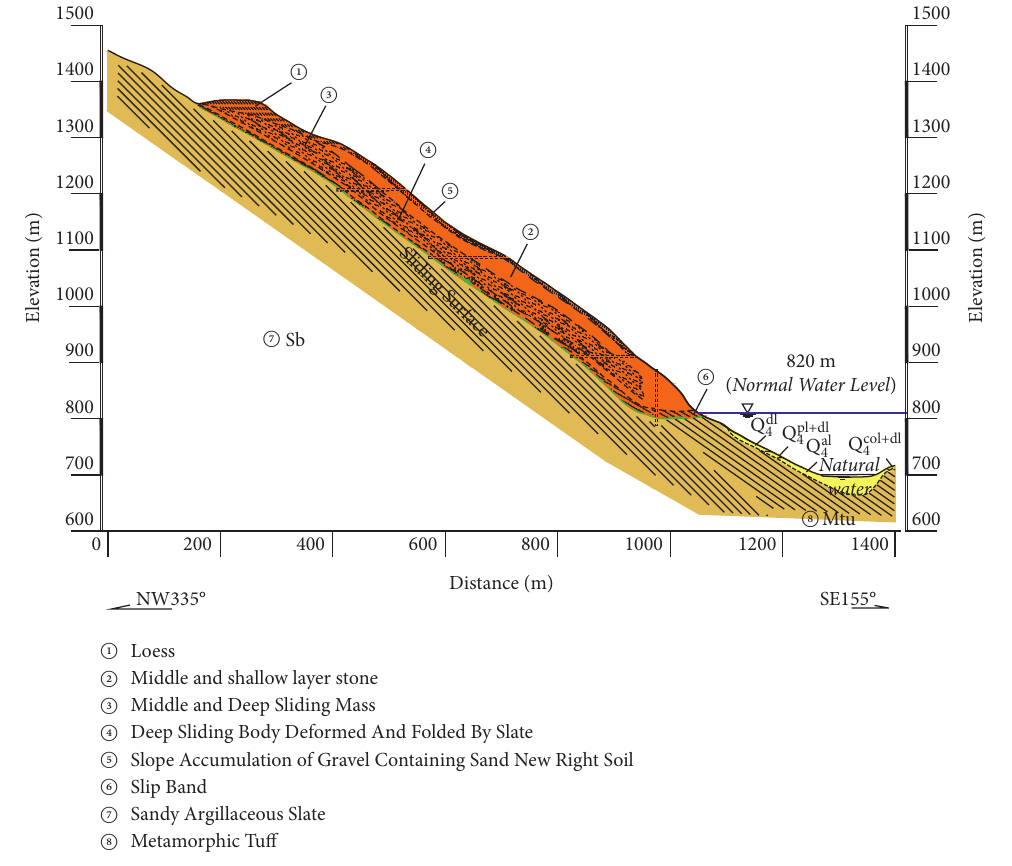
Figure 4: Typical geological profile of the Hejia landslide.